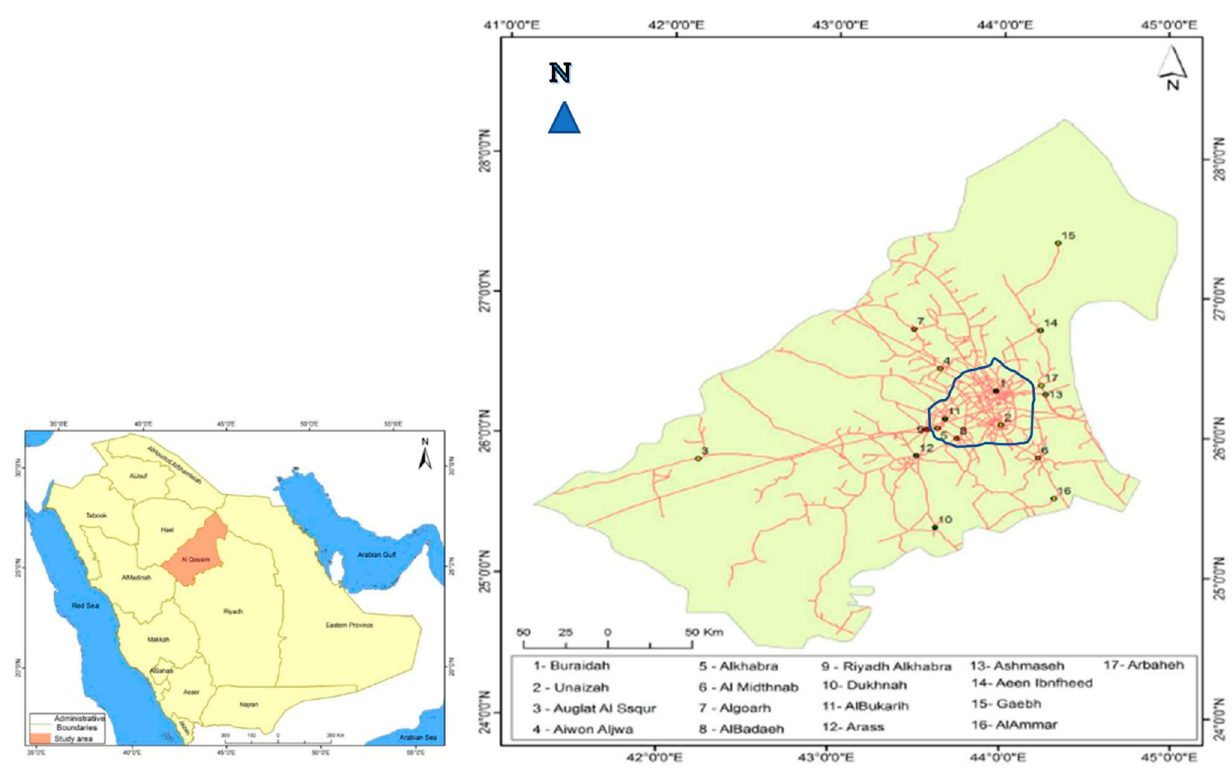
Figure 2. Road network of Qassim Region. Qassim region is highlighted on small Saudi Arabia’s map given in the left side of the figure. Blue boundary marks the study area boundaries in Qassim Region.